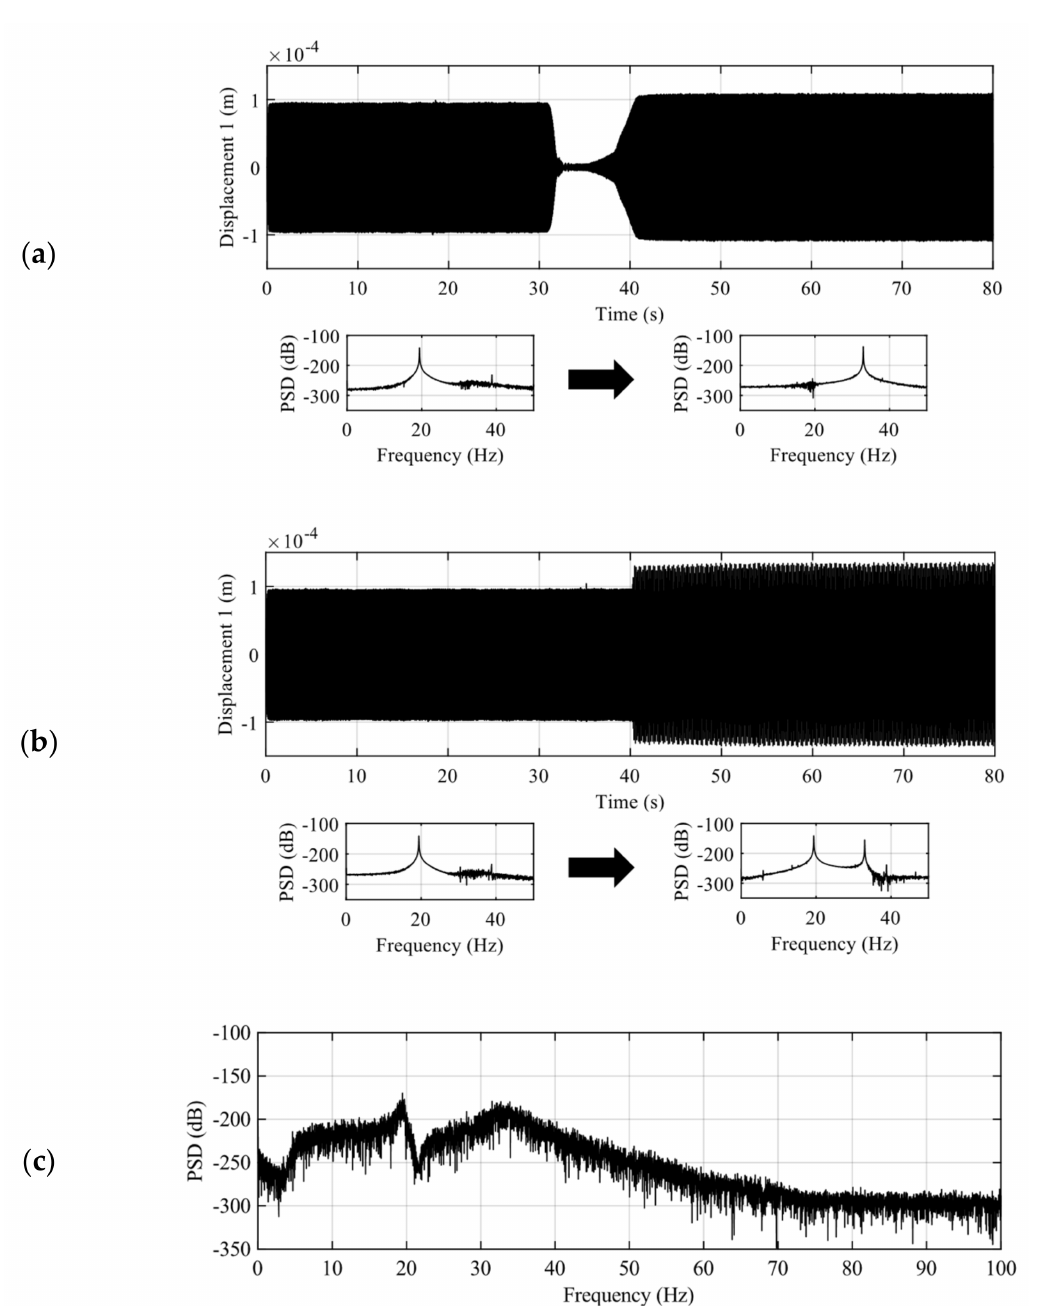
Figure 6. Three nonstationary and random disturbance conditions in the experiments. ( a ) Frequency sweep vibration experiment: the upper figure shows the time history of displacement 1; the lower figures show each PSD in response to vibration changes. ( b ) Change in the number of dominant frequency vibration experiment: each figure shows the same information as ( a ). ( c ) Random vibration experiment: sample PSD is